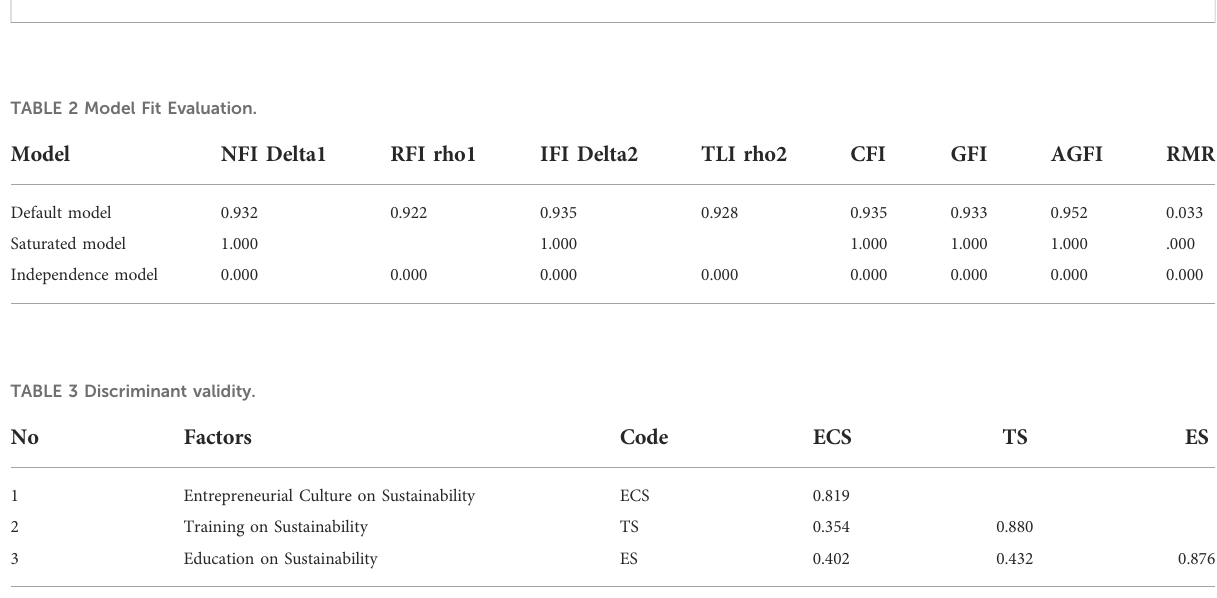
FIGURE 2 Model fi t measurement.